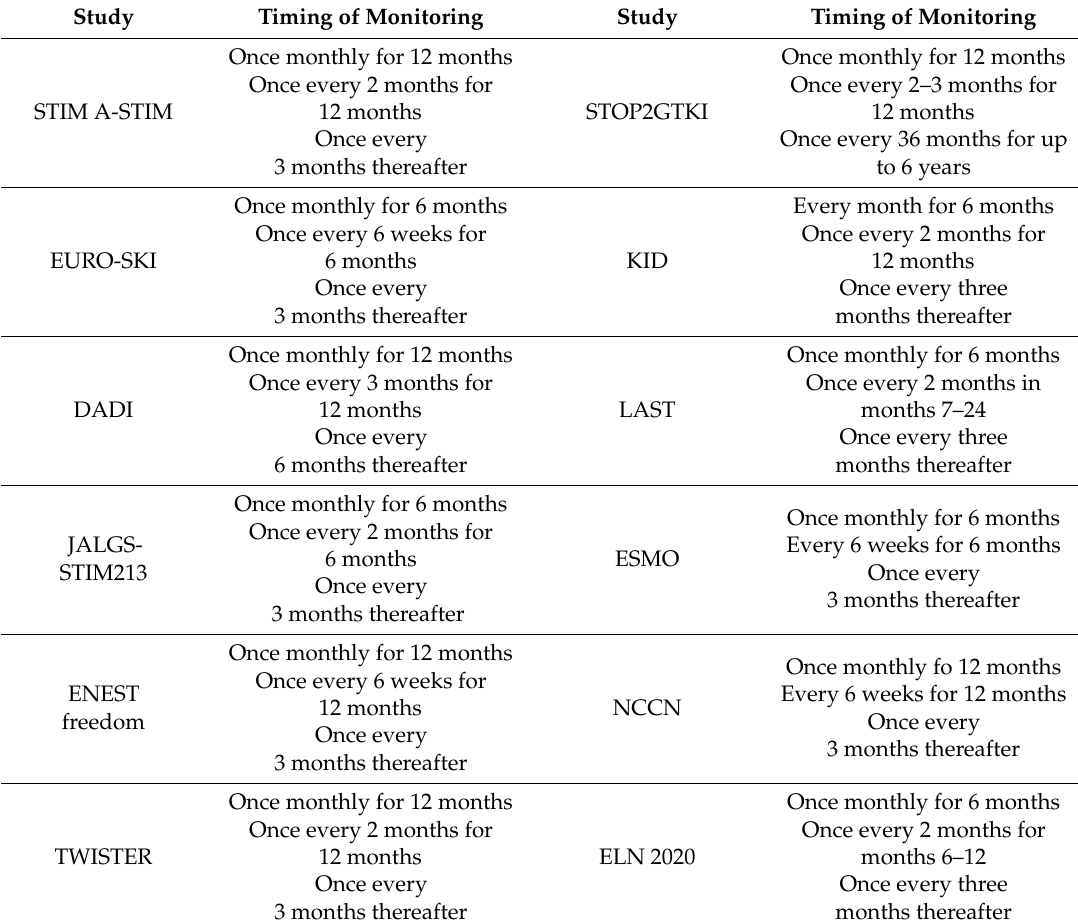
Table 3. Timing of molecular monitoring in prospective trials and current